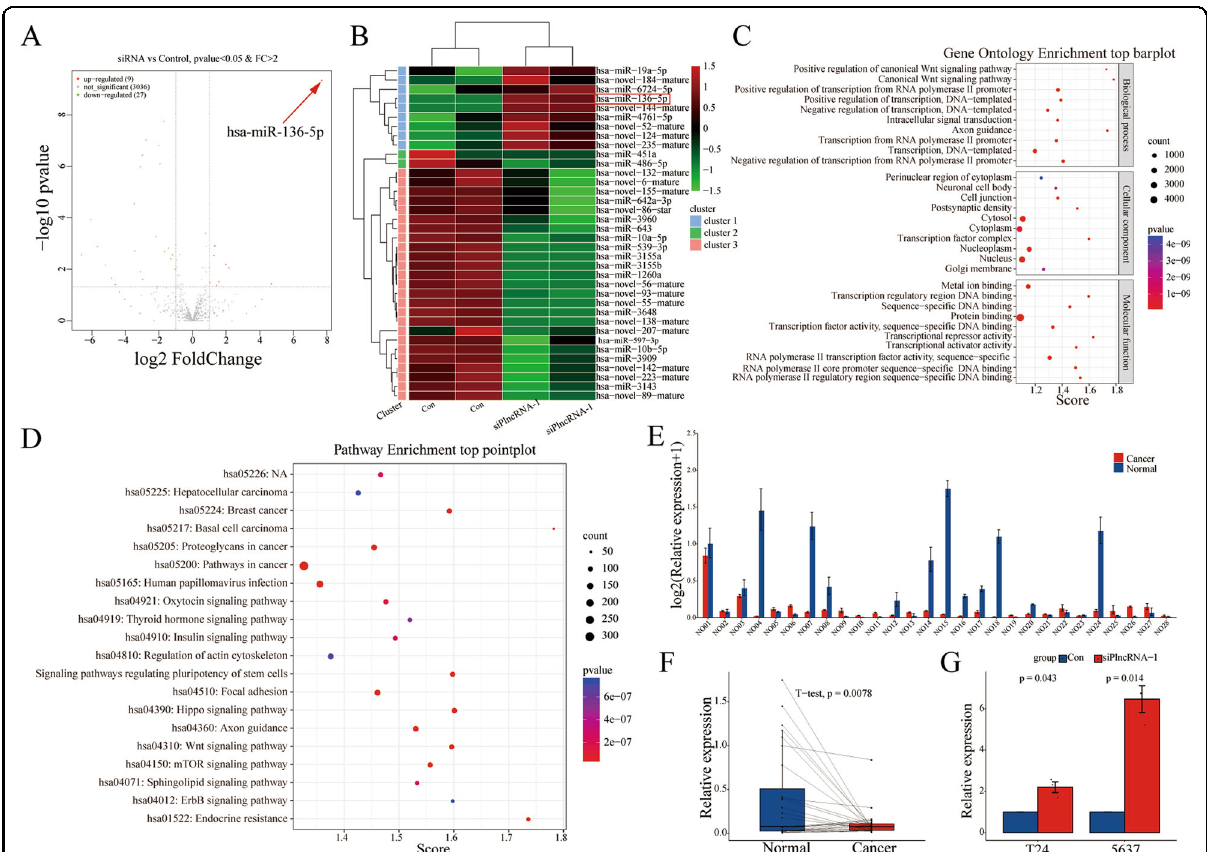
Fig. 6 The regulatory effect of PlncRNA-1 on the expression of miR-136. A Volcano plots for the differential expression of miRNA between siPlncRNA-1 and the control group (Red — high expression; blue — low expression). B Heatmap for the differential expression of miRNA between siPlncRNA-1 and control group (Red indicates high expression; blue indicates low expression). C GO analysis for miRNA-predicted target genes. D KEGG analysis for miRNA-predicted target genes. E , F The expression of miR-136 in 28 pairs of normal and BC tissues. G qPCR analysis for the expression of miR-136 in BC cells after PlncRNA-1